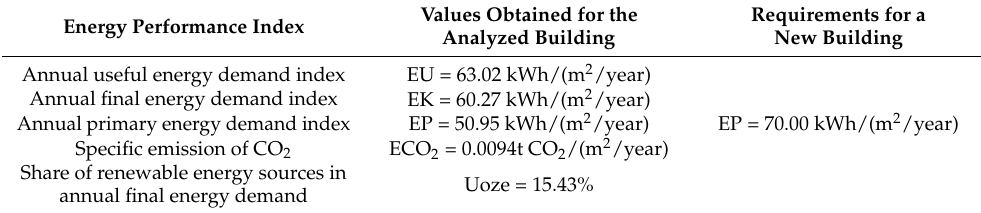
Table 4. Energy performance of a building using a heat pump in the heating system.